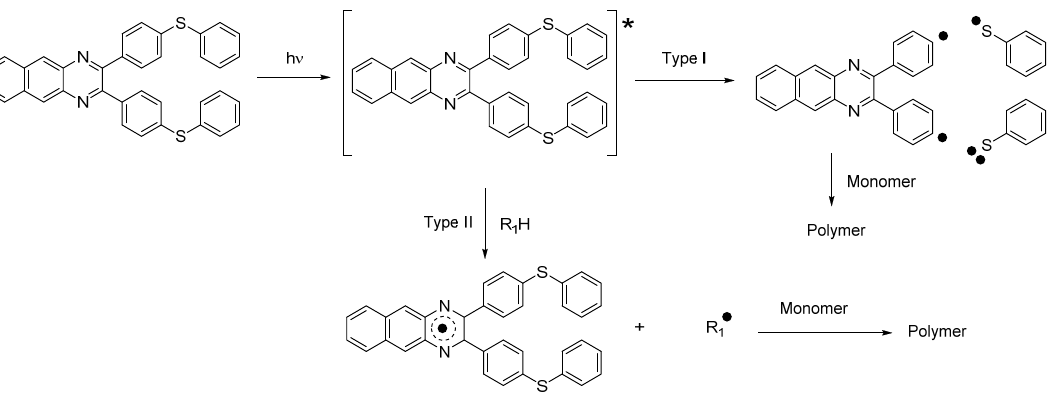
Scheme 6. Mechanism of photoinitiation with diphenylquinoxaline derivatives (SQs) comprising phenyl-thioether units (* corresponds to the excited state).